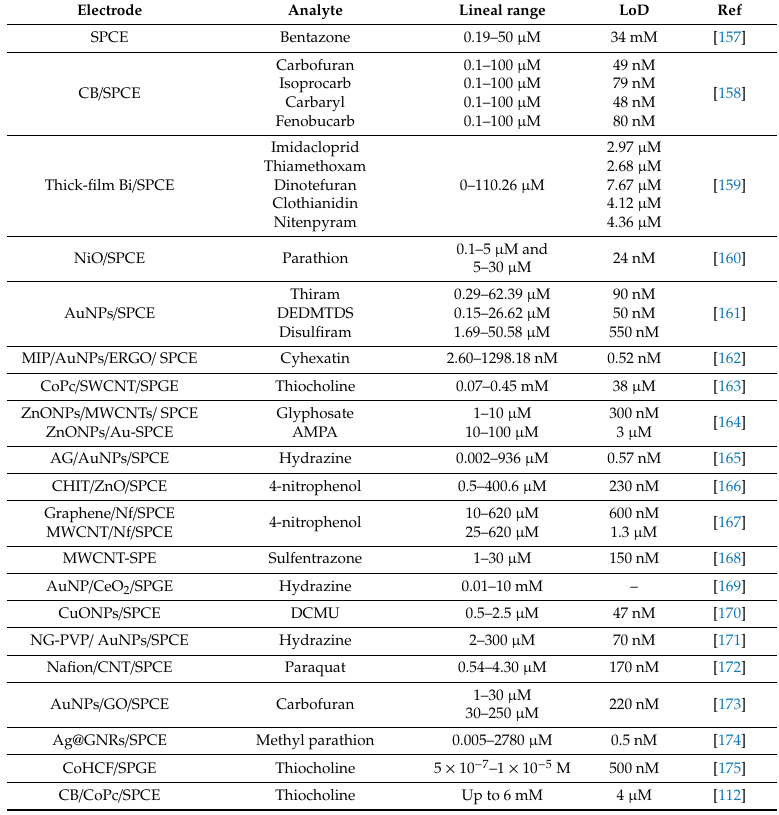
Table 3. Direct detection-based biosensors reported for pesticides determination on screen-printed